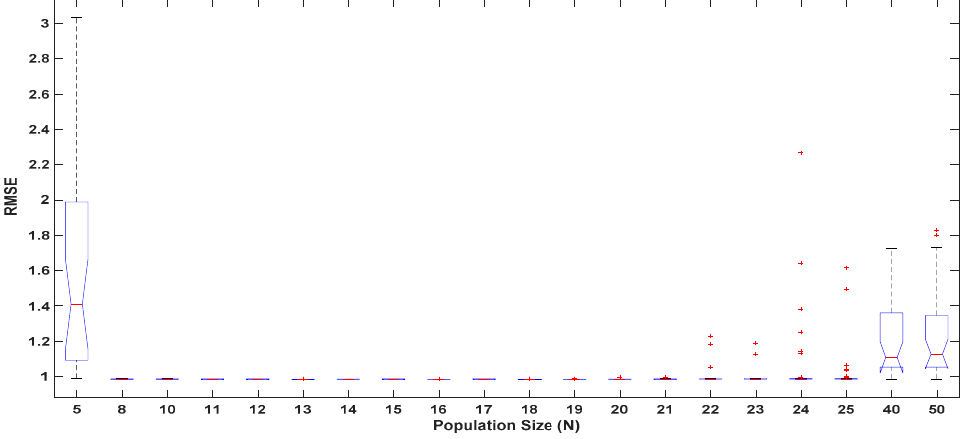
Figure 5. Tuning of the N parameter. Table 5. Parameter settings of the compared algorithms.